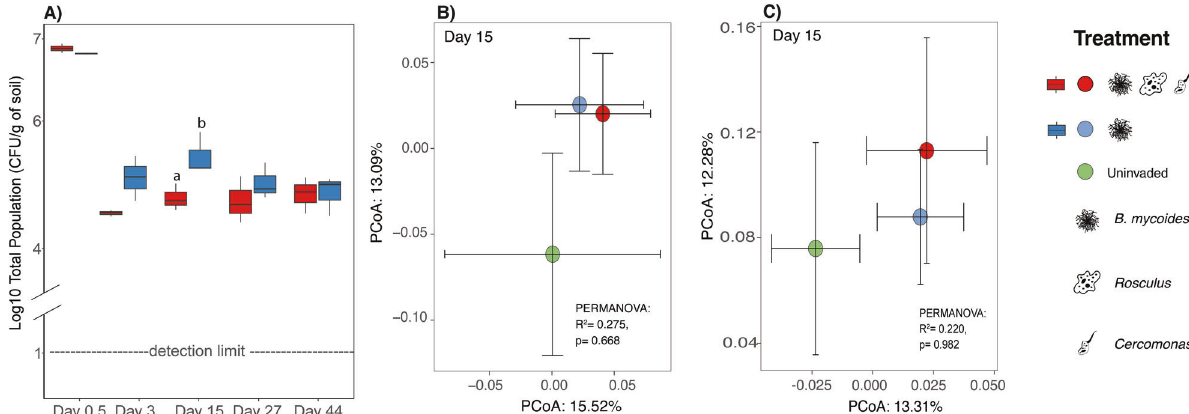
Fig. 2 Survival of Bacillus mycoides M2E15 and the impact of inoculation treatments on the soil bacterial and protist communities structure. ( A ) Survival of B. mycoides M2E15 in the presence and absence of Rosculus terrestris ECOP02 and Cercomonas lenta ECOP01 over time. Values represent the log CFU of the population per gram of soil. Bars represent the standard error of the mean. Inoculation treatment affects the soil bacterial ( B ) and protist ( C ) communities. Centroids for each treatment are shown along with their standard errors (error